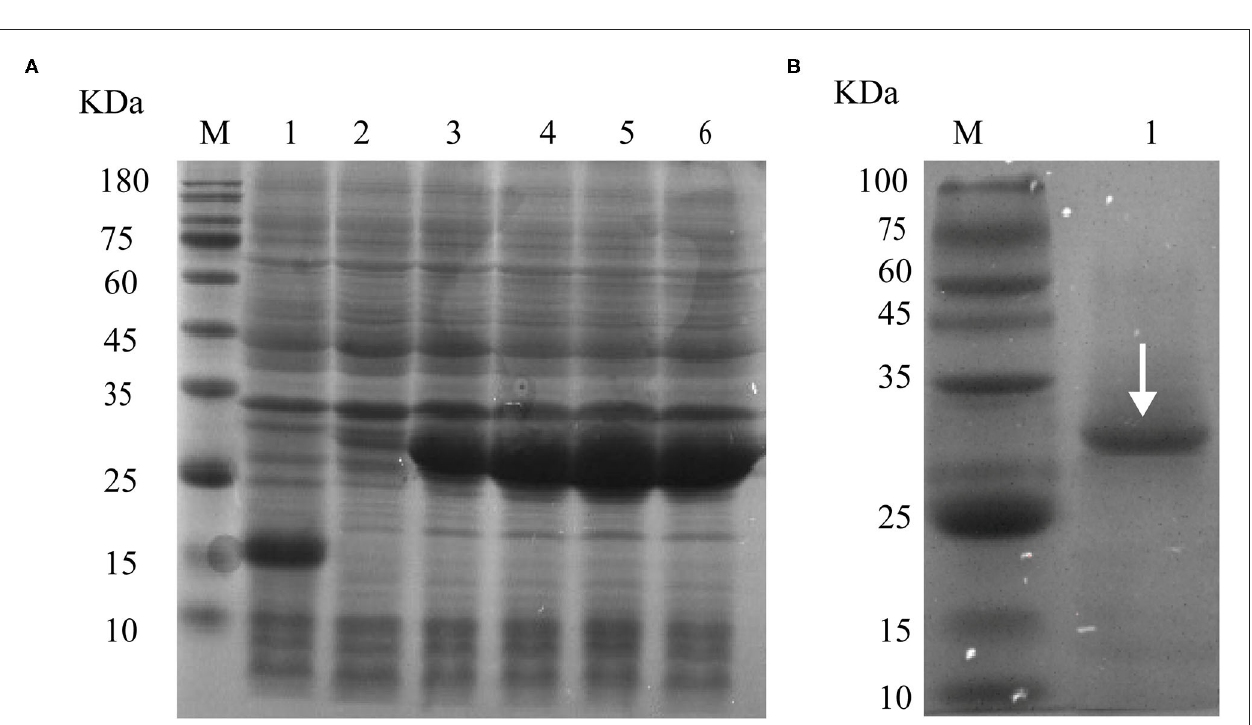
FIGURE 3 | Neighbor Joining phylogenetic tree constructed using Eg-TSP11 and TSP proteins from other species.